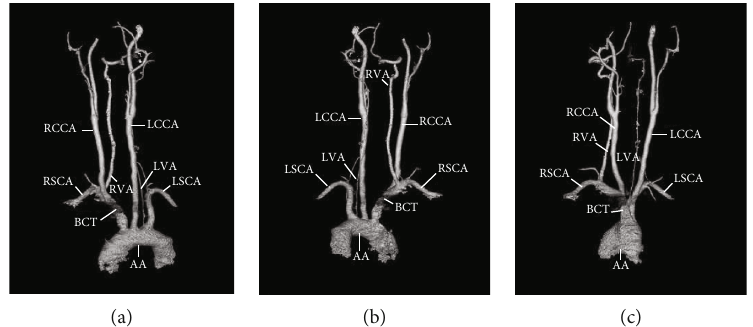
Figure 2: Computed tomographic angiography demonstrates the anterior-posterior (a), posterior-anterior (b), and lateral (c) views. AA = aortic arch; BCT = brachiocephalic trunk; LCCA = left common carotid artery; LSCA = left subclavian artery; RCCA = right common carotid artery; RSCA = right subclavian artery; LVA = left vertebral artery; RVA = right vertebral